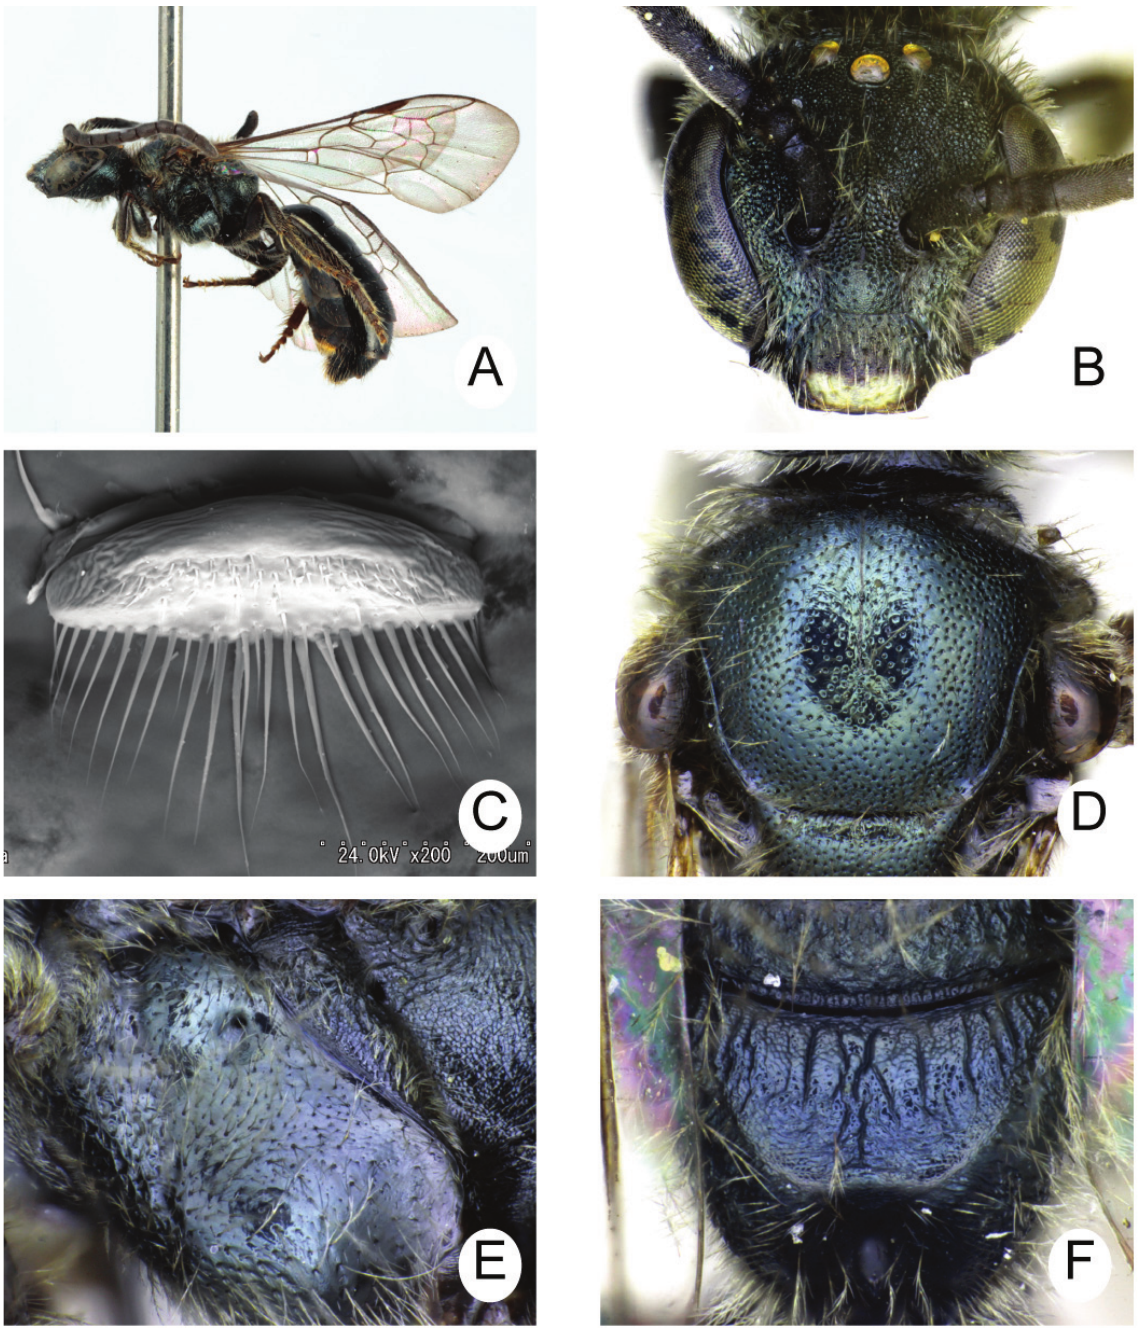
Fig. 17. Lasioglossum ( Dialictus ) alishanense Murao sp. nov., ♂. A . Lateral habitus. B . head in frontal view. C . Labrum. D . Mesoscutum. E . Mesepisternum. F . Metapostnotum. a–B, e–F. holotype. c–d.